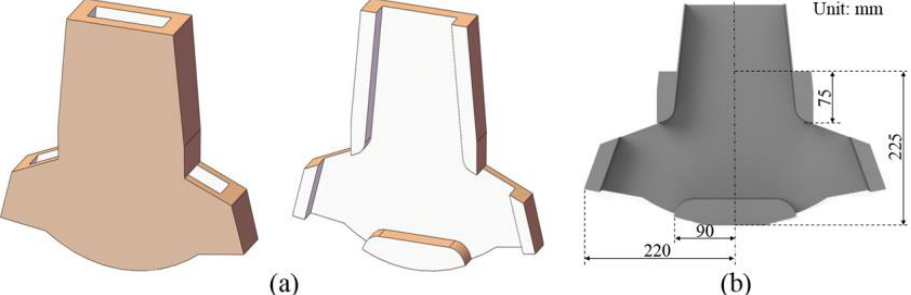
Figure 3. Schematic diagram of submerged entry nozzle of the CSP mold: ( a ) the geometric model of the SEN and ( b ) the dimensions of the SEN. Figure 4. Schematic diagram of submerged entry nozzle of the FTSR mold: ( a ) the geometric model of the SEN and ( b ) the dimensions of the SEN.